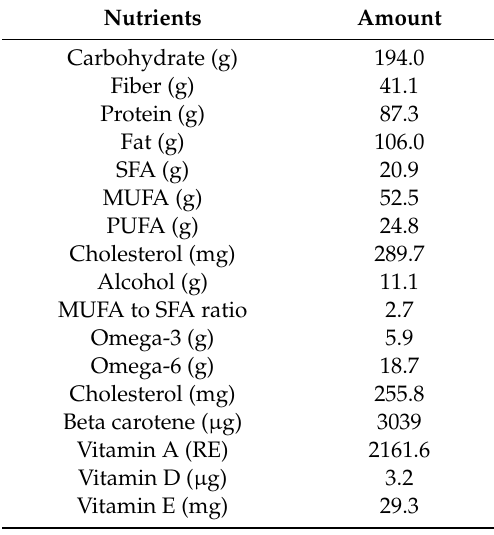
Table 1. Daily nutritional suggested composition for the experimental MedDiet (2240 kcal /